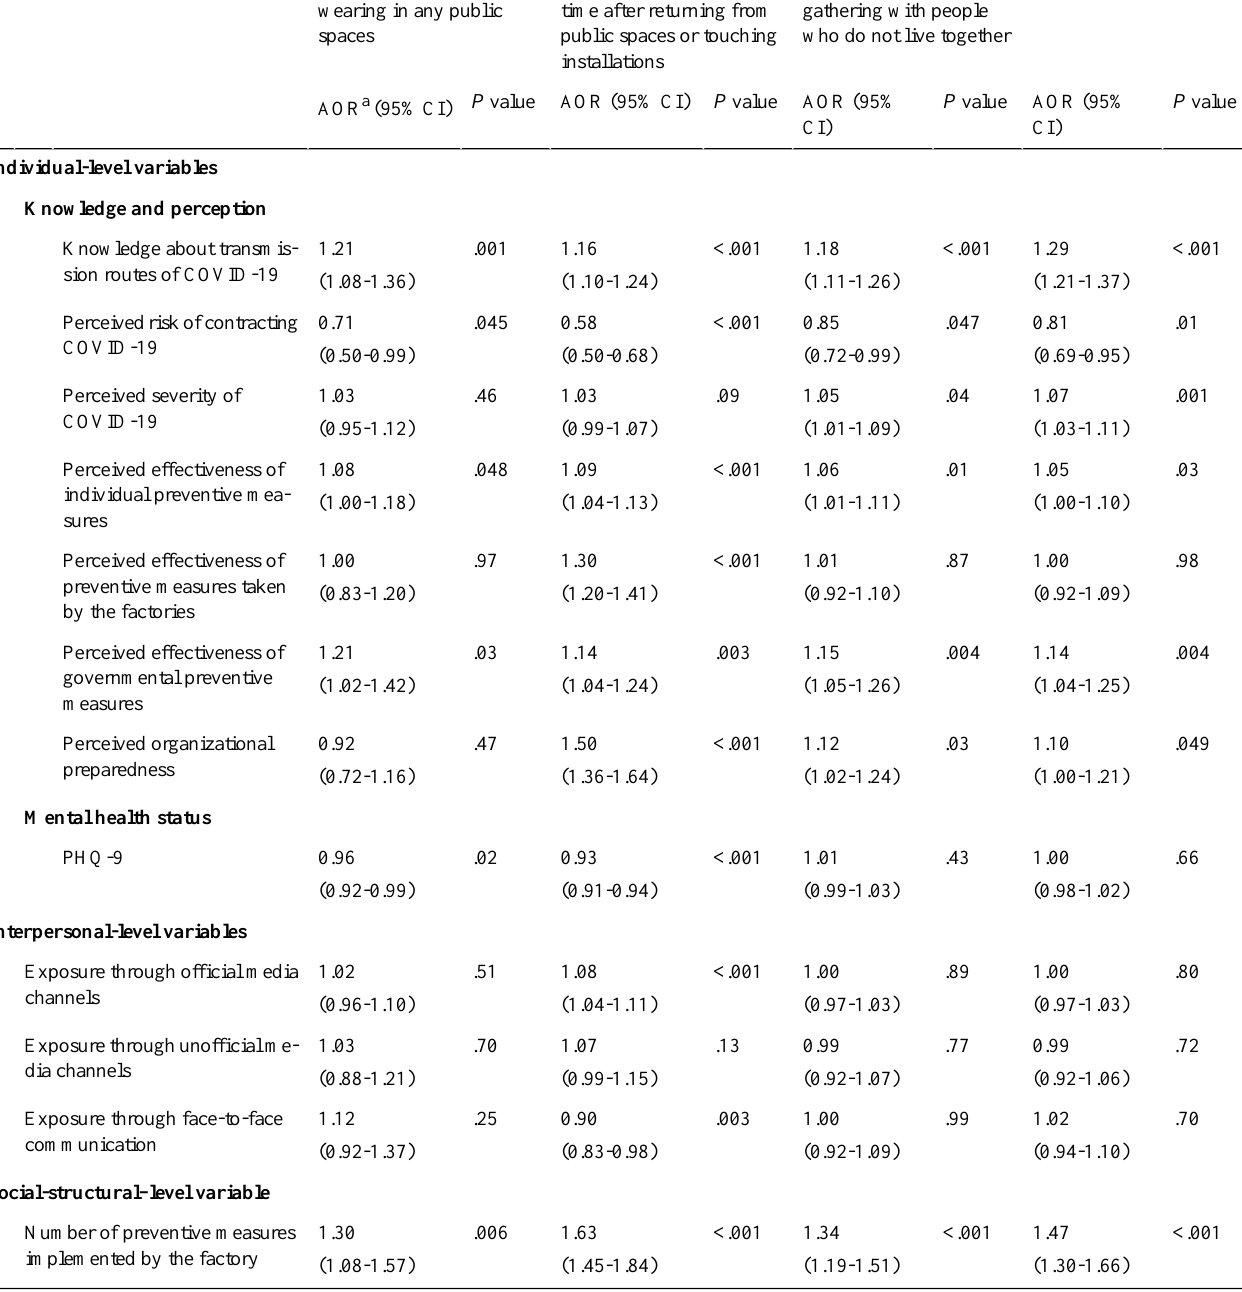
Avoiding crowded placesAvoiding social/meal gathering with people who do not live